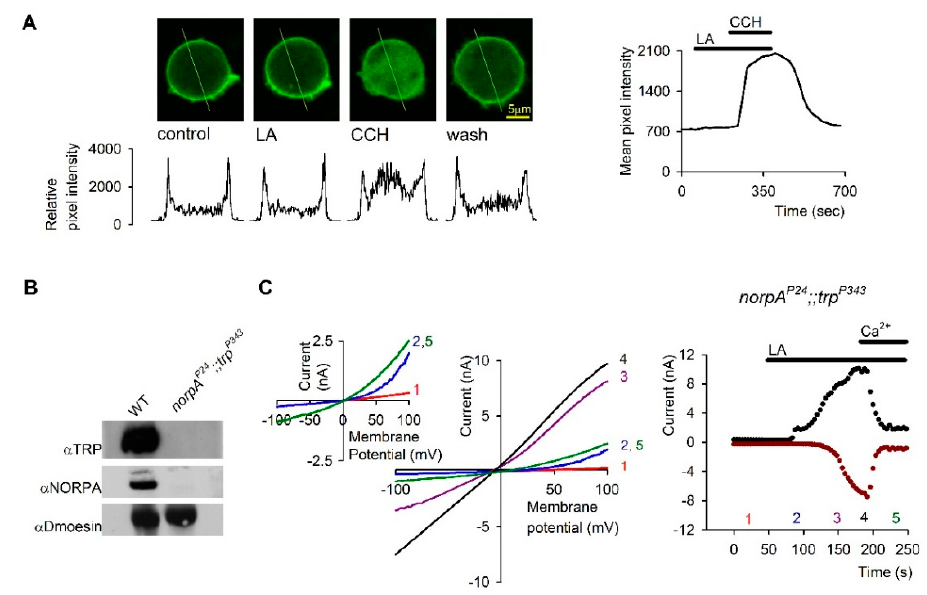
Figure 5. The action of Linoleic Acid (LA) is not mediated via PLC: ( A ): PLC activity was monitored by using S2 cells expressing the Drosophila muscarinic receptor (DM1) and eGFP-PH, which binds to PIP 2 and IP 3 . Application of 50 µ M LA, under conditions which activated the channels, did not elicit any change in the eGFP-PH distribution, as monitored by confocal images of the GFP fluorescence (LA) relative to control. Application of carbachol (CCH) elicited a robust translocation of eGFP-PH to the cytosol, which was reversed by CCH removal (wash), thus indicating activation of PLC ( n = 6). The relative fluorescence intensity at a cross section of the cell (marked by line) is also presented below the confocal images. The time course of the fluorescence changes measured in the cytosol is presented on the right. ( B ). Western blot analysis of heads homogenate of dark raised WT and norpA p24 ;;trp P343 double null mutant flies. Head membrane was extracted with SDS buffer and subjected to Western blot analysis with antibodies specific for the Drosophila proteins TRP, NORPA and Dmoesin as indicated. No TRP and NORPA proteins were detected in the norpA p24 ;;trp P343 double mutant. (C) . Left , Representative I-V curves measured by whole cell recordings from photoreceptors of the norpA P24 ;;trp P343 mutant lacking PLC and the TRP channel (see Figure 5B). In darkness the TRPL channels are closed (red curve 1). The effect of the 60 µ M LA was not altered by the absence of PLC and a linear I-V curve was obtained (black curve 4). The effect of LA at positive membrane potentials preceded that of negative membrane potentials (Curves 2 and 3, blue and purple respectively) in a similar manner to the results of S2. Application of 10 mM Ca 2+ restored the outward rectifying I-V curve (green curve 5). Inset, enlargement of curves 1, 2 and 5, demonstrating more clearly the outward rectification. Right , the effect of LA on the current is presented at 90mV (black dots) and − 90mV (dark red dots) as a function of time. The numbers correspond to the curves presented in the left ( n = 4). (From [78], Copyright 2000 Society for Neuroscience).